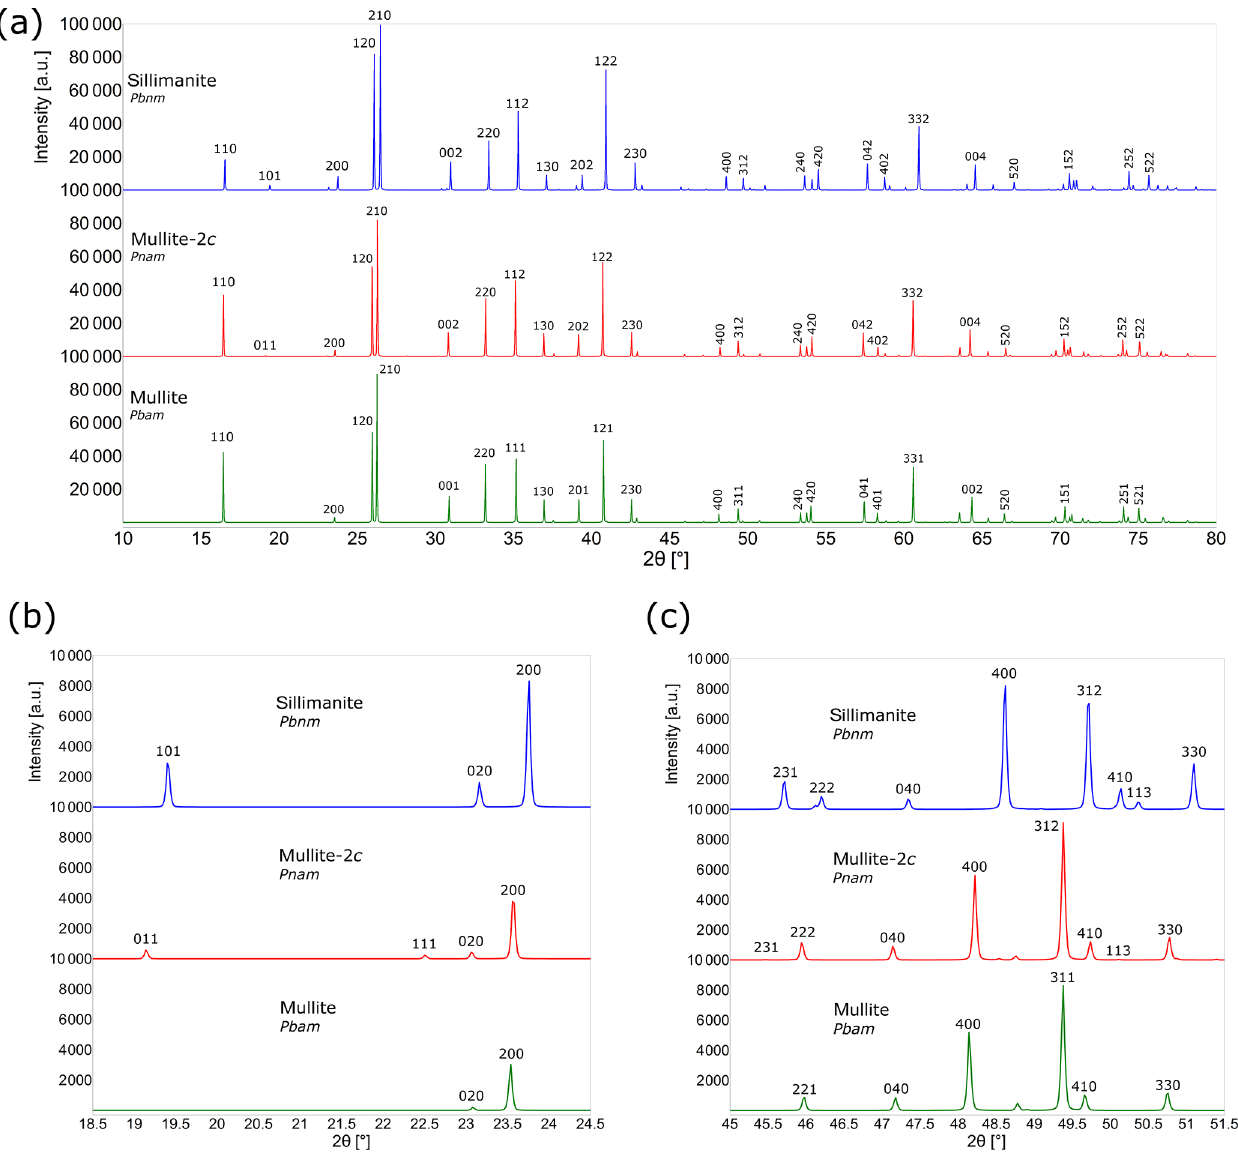
Figure 6. Comparison of the calculated powder XRD patterns (Cu Kα ) for sillimanite, mullite-2 c and mullite. (a) Simulated powder diffrac- tograms from 10 to 80 ◦ 2 θ . (b) Powder patterns from 18.5 to 24.5 ◦ 2 θ . (c) Details in the powder diffraction patterns from 45 to 51.5 ◦ 2 θ . The 231 peak of mullite-2 c barely